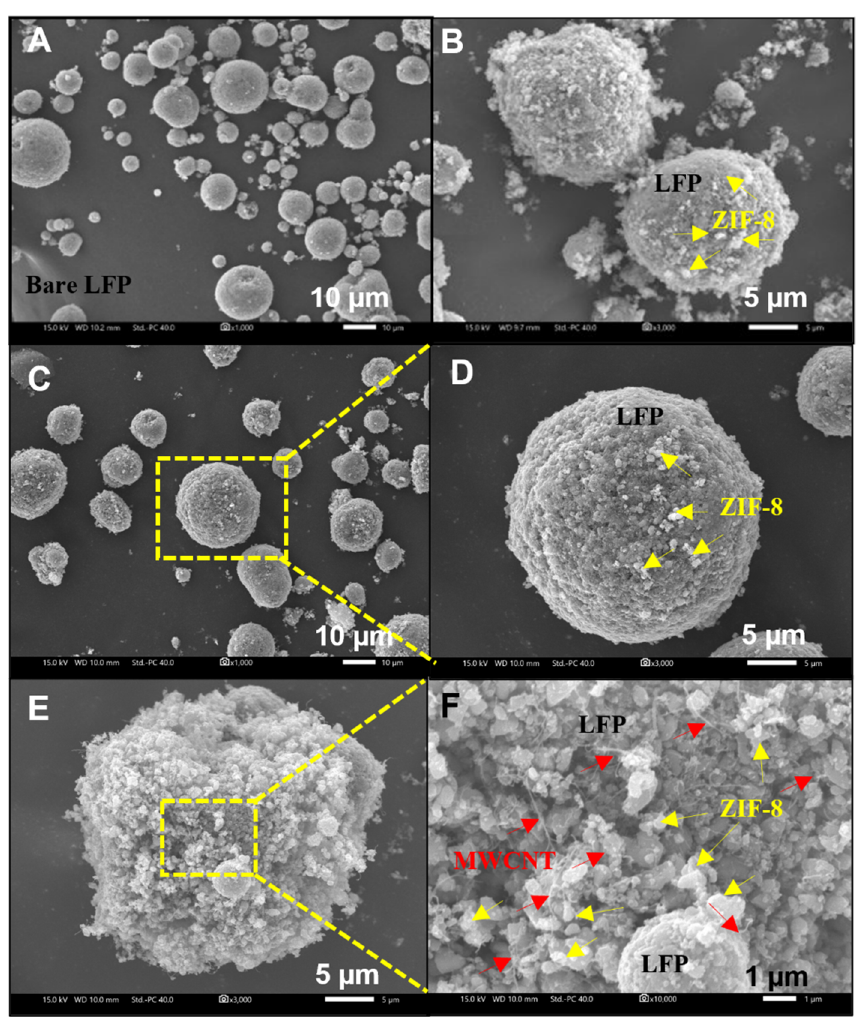
Figure 1. SEM images of the ( A ) bare LFP, ( B ) 2 wt.% ZIF-8@LFP [MS], ( C , D ) 2 wt.% ZIF-8@LFP [A], and ( E , F ) 2 wt.% ZIF-8@LFP [A]/MWCNT